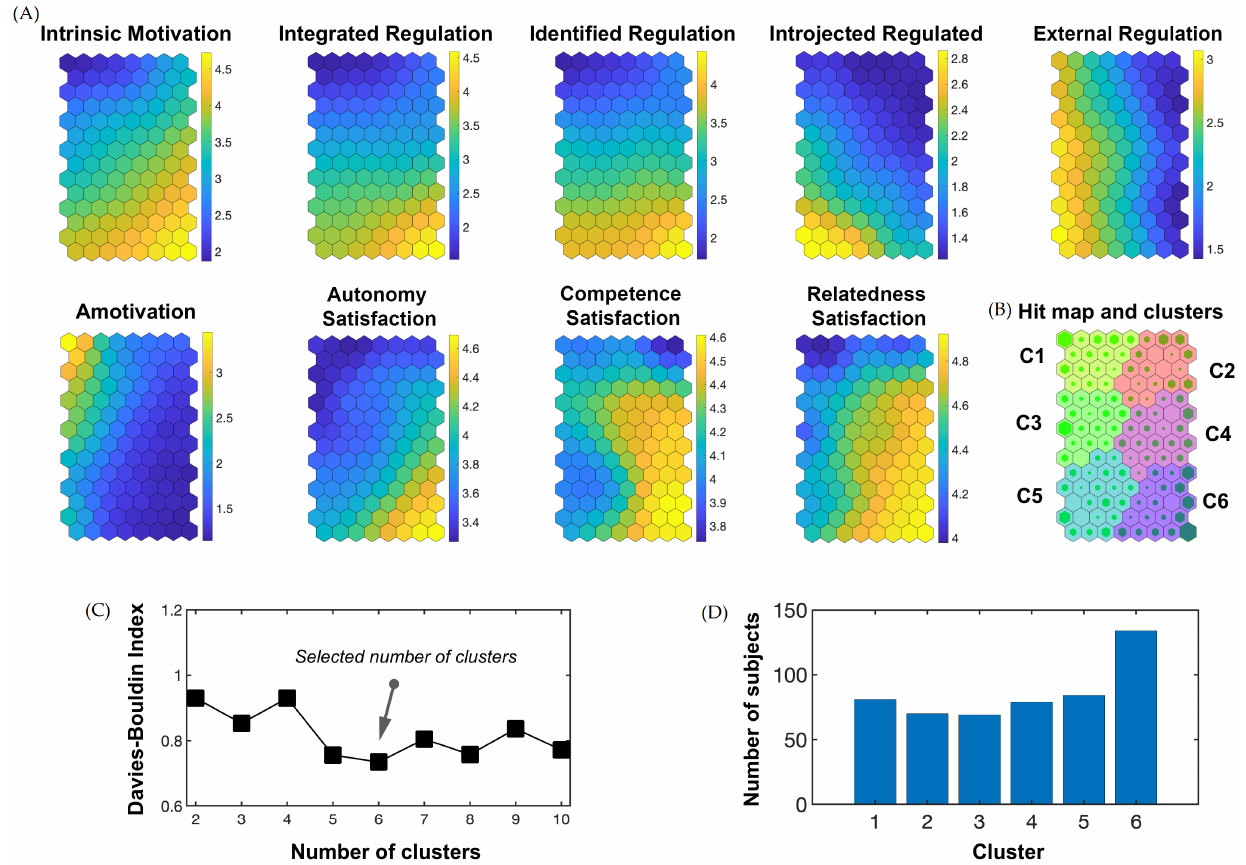
Figure 1. Component planes, clusters (C1–C6), and hits obtained by the SOM analysis. ( A ) Com- ponent planes of the nine input variables (intrinsic motivation, integrated regulation, identified regulation, introjected regulation, external regulation, amotivation, autonomy satisfaction, compe- tence satisfaction, and relatedness satisfaction). Yellow neurons indicate comparatively high values; dark blue neurons indicate comparatively low values, depending on the sample’s distribution. ( B ) Hit map with the six clusters (C1–C6). The bigger the green filling of a neuron, the higher the number of adolescents assigned to the neuron. ( C ) Quantization error according to the possible number of clusters selected. ( D ) Overview on number of participants in every cluster.